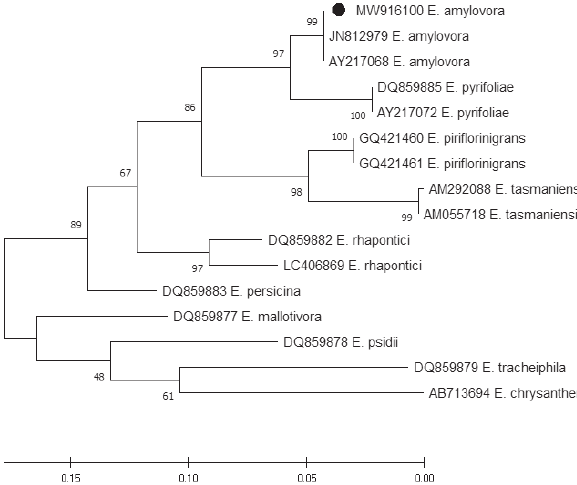
Figure 3. Phylogenetic analysis based on recA gene sequences from diverse Erwinia spp. strains. The evolutionary history was inferred by using the Maximum Likelihood method and Tamura-Nei model (Tamura and Nei, 1993). The tree with the greatest log likelihood (-1905.63) is shown. The percentage of trees in which the associ- ated taxa clustered together is shown next to the branches. Number of boostrap replicates = 500. Initial tree(s) for the heuristic search were obtained automatically by applying Neighbor-Join and BioNJ algorithms to a matrix of pairwise distances estimated using the Tamura-Nei model, and then selecting the topology with superior log likelihood value. The tree is drawn to scale, with branch lengths measured in the number of substitutions per site. This analysis involved 16 nucleotide sequences. Codon positions included were 1st+2nd+3rd+Noncoding. There was a total of 399 positions in the final dataset. Evolutionary analyses were conducted in MEGA X (Kumar et al., 2018). The sequence obtain in the present study is marked with a black